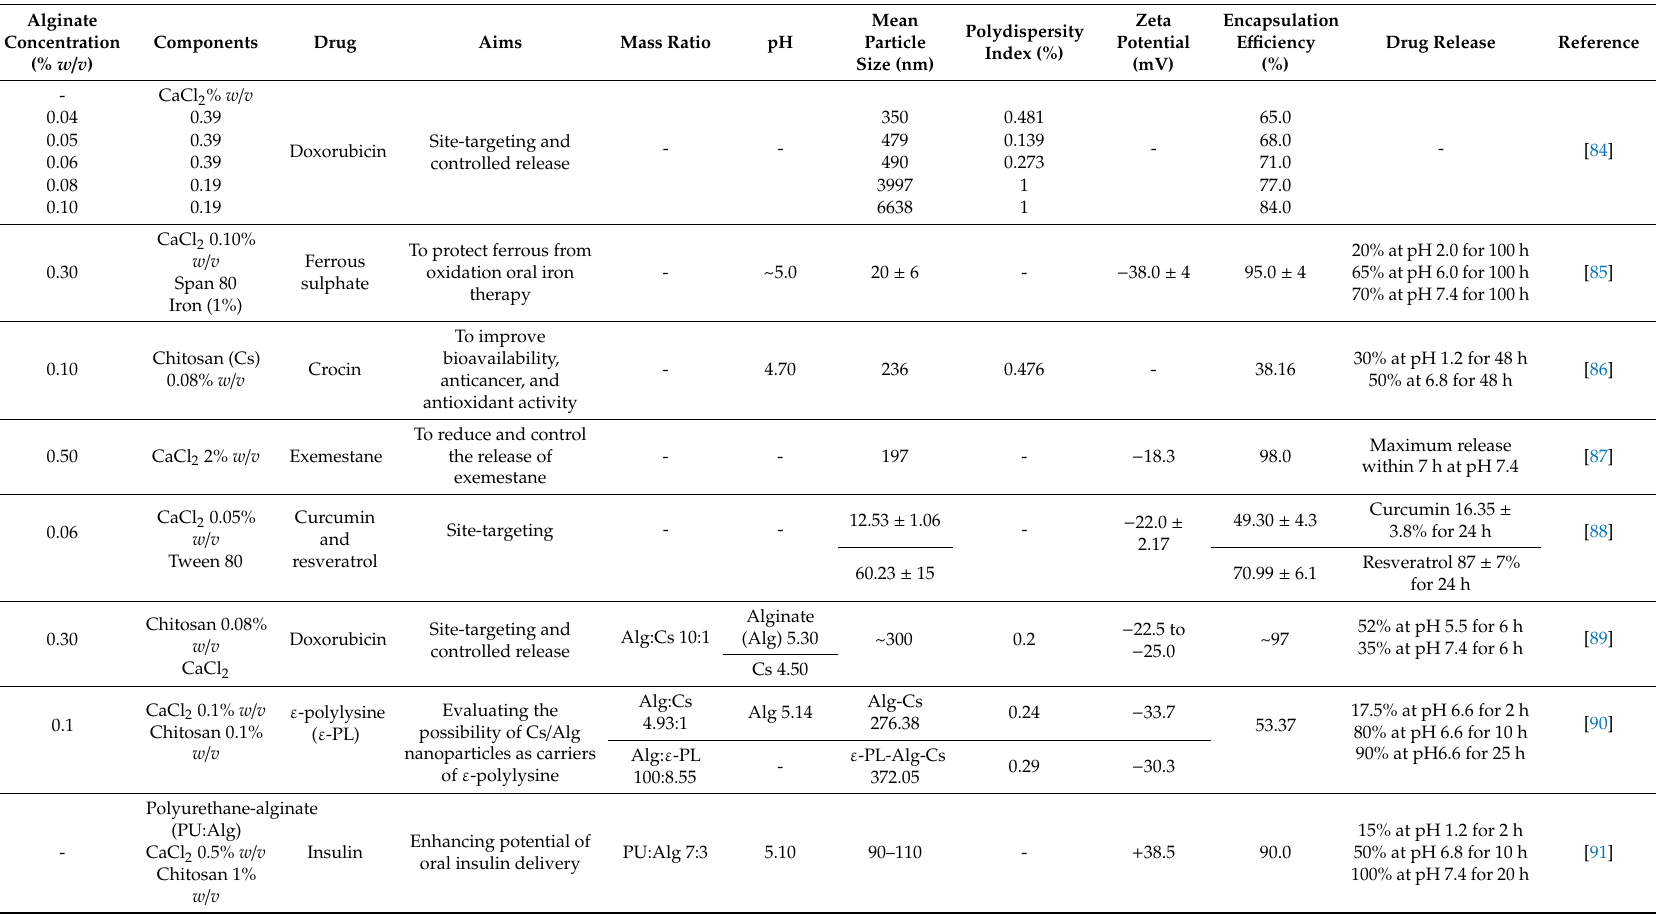
Table 1. Example of polymeric nanoparticles formulation by complexation